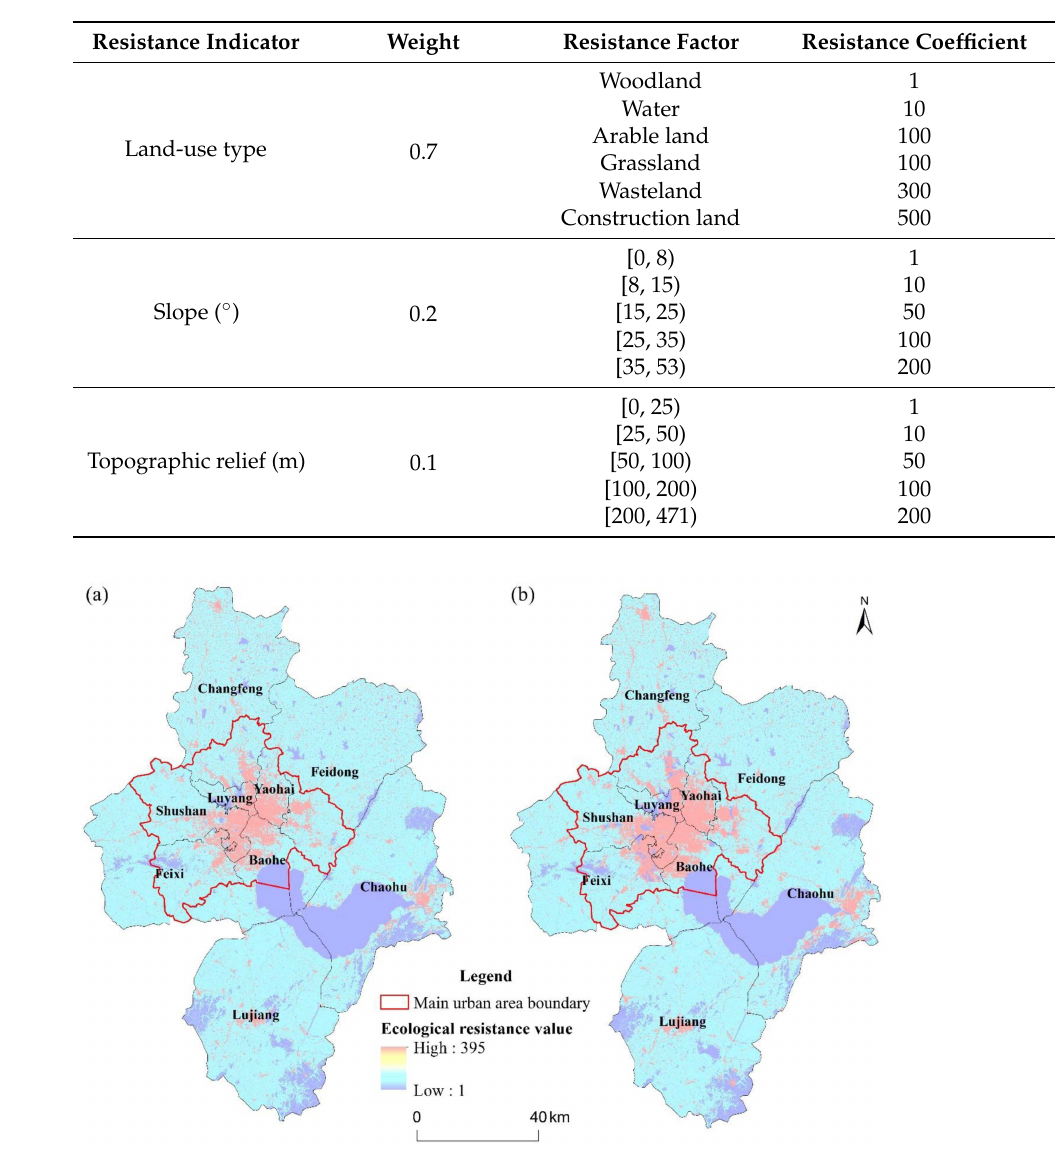
Table 3. Resistance value for each resistance factor.